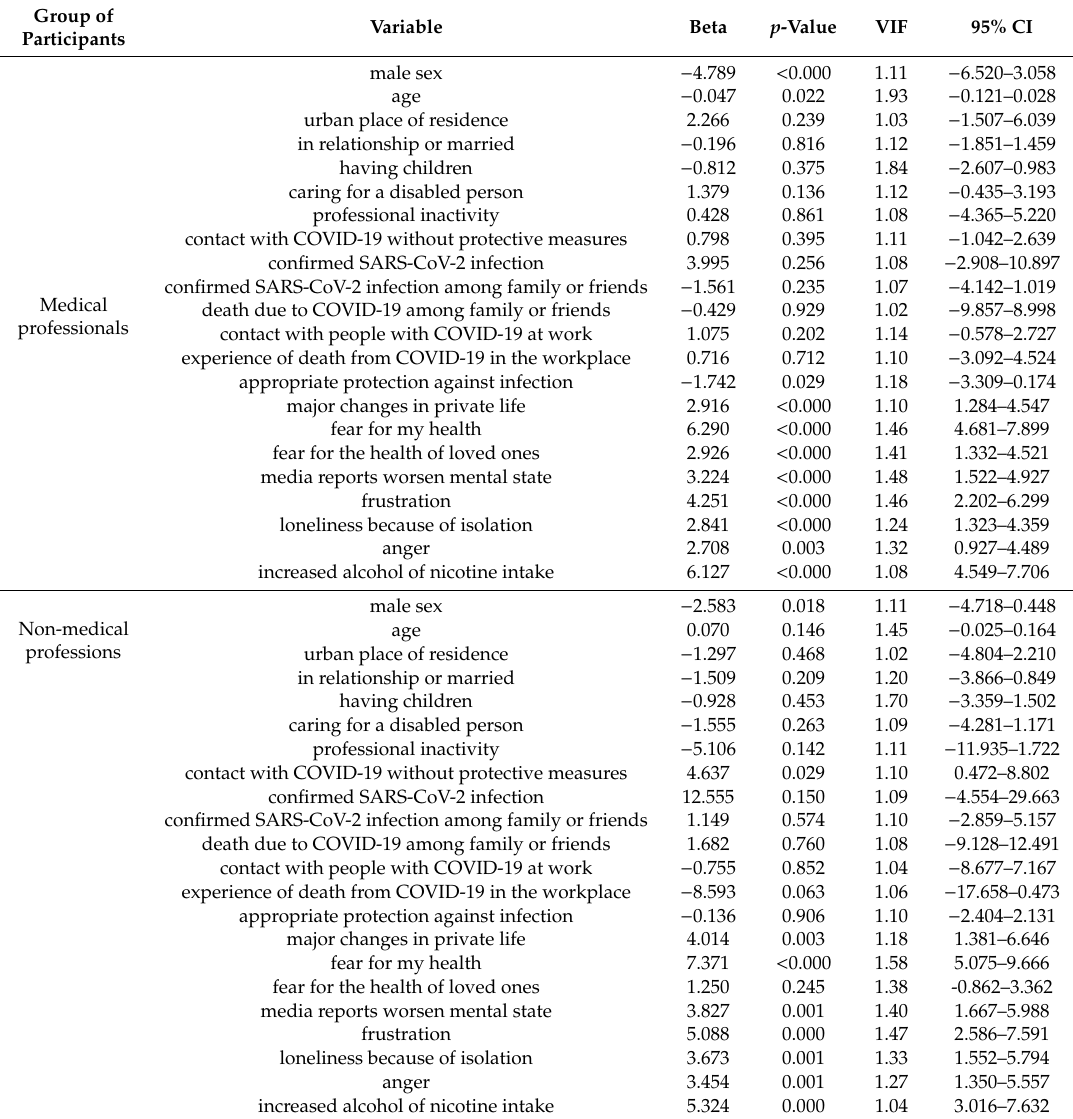
Table 4. Factors related to the GHQ-28 total scores in medical and non-medical professionals (results of linear regression